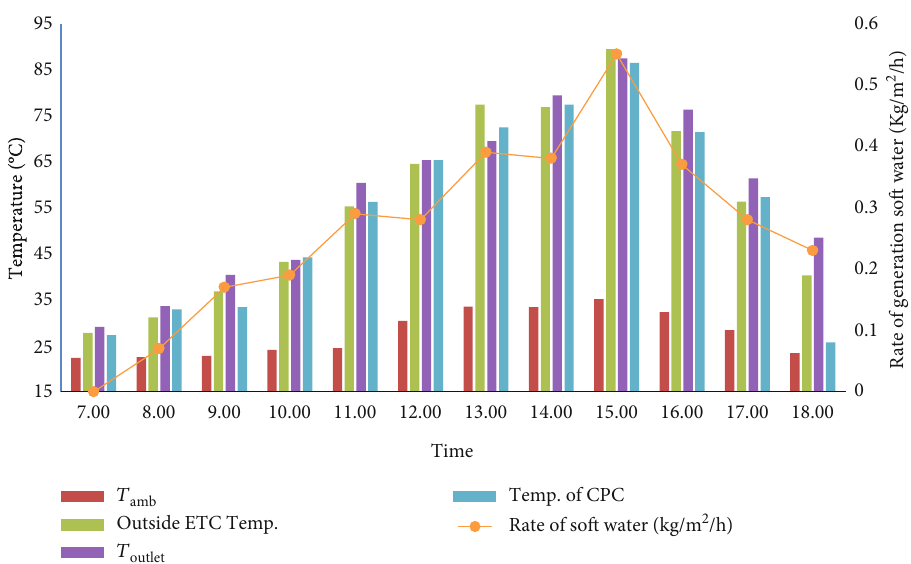
Figure 9: Variations of the rate of generation and measuring temperatures versus time (chrome mirror silver vinyl wrap). Table 5: Hourly variations of measured parameters in May 2018 with Mylar material of CPC. Ambient The intensity of solar Time ) radiation ( I g